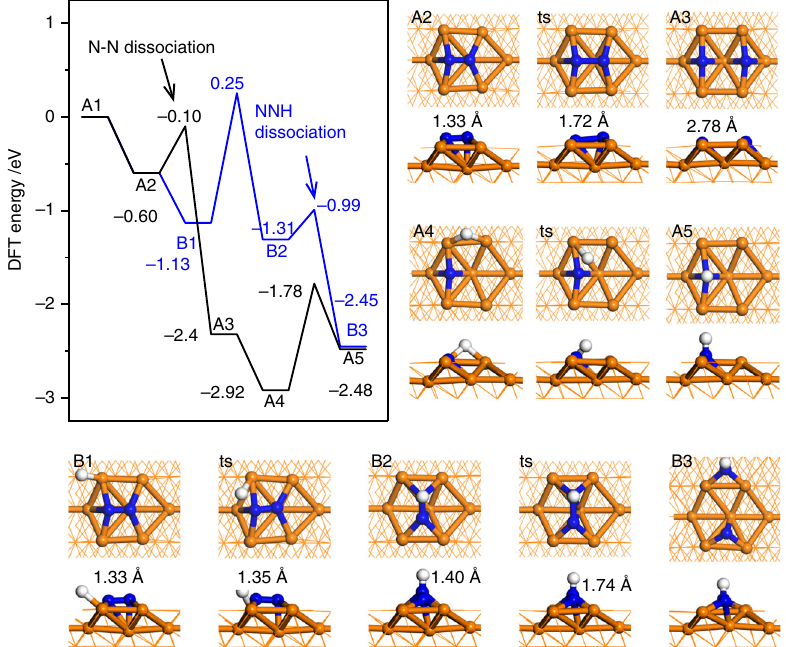
Fig. 2 The energy diagram for the fi rst two steps of NH 3 synthesis on Fe(211) C7 site. The black line is for the dissociative mechanism, where *N 2 dissociates directly, and the blue line for the associative mechanism, where the N – N bond breaks only after hydrogenation to the *NNH